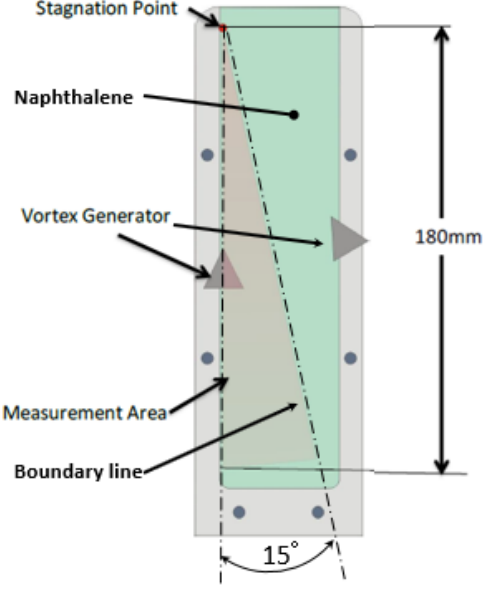
Figure 9. Location of VGs on the naphthalene target plate.